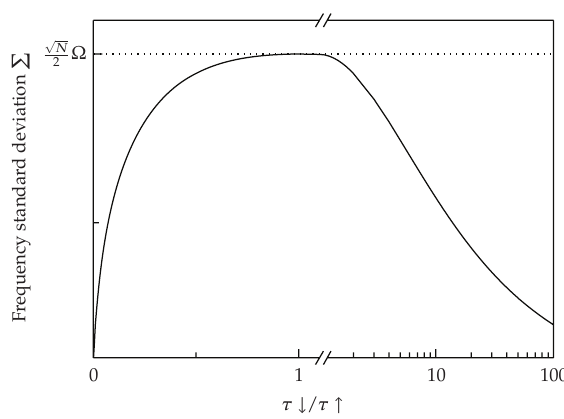
Figure 3: Standard deviation Σ of the frequency versus ratio of the jump processes characteristic times τ ↓ /τ ↑ . The dotted line indicates the maximum value of the standard deviation Σ s (cid:8) for symmetric jump processes τ ↓ (cid:8) τ ↑